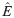
The cumulative distribution of coalescent event times for the networks and epidemic dynamics shown in Fig 1.Grey lines show the observed distribution of coalescent events obtained by tracking two randomly sampled lineages back in time until they coalesce in 500 individual-based stochastic simulations. Colored lines show the theoretically predicted coalescent densities under the pairwise coalescent (blue), the random mixing coalescent (red) and the random mixing coalescent conditioned on the mean dynamics provided by the pairwise epidemic model (green). The E^ values give the mean time-integrated error in the coalescent density predicted by each model relative to the stochastic simulations. (a-c) Homogenous networks with varying overall connectivity k^. (d-f) Homogenous networks with different clustering coefficients ϕ. (g-i) Heterogenous networks with different variances σk2 in the degree distribution. (j-l) Heterogenous networks with different assortativity coefficients r. All network and epidemiological parameters are the same as in Fig 1.